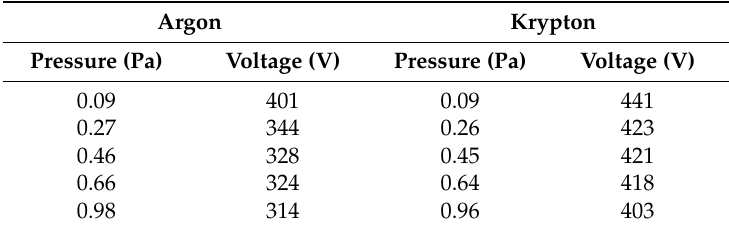
Figure 2. Experimental setup with seven substrates positioned at α ϵ {0°, ±22.5°, ±45° and ±67.5°} angle arrangement with respect to the target normal and a target-substrate distance of approximately 70 mm. Table 1. Ar and Kr gas pressures and measured target voltages which correspond to impinging ion energies for Ar + and Kr + ions.